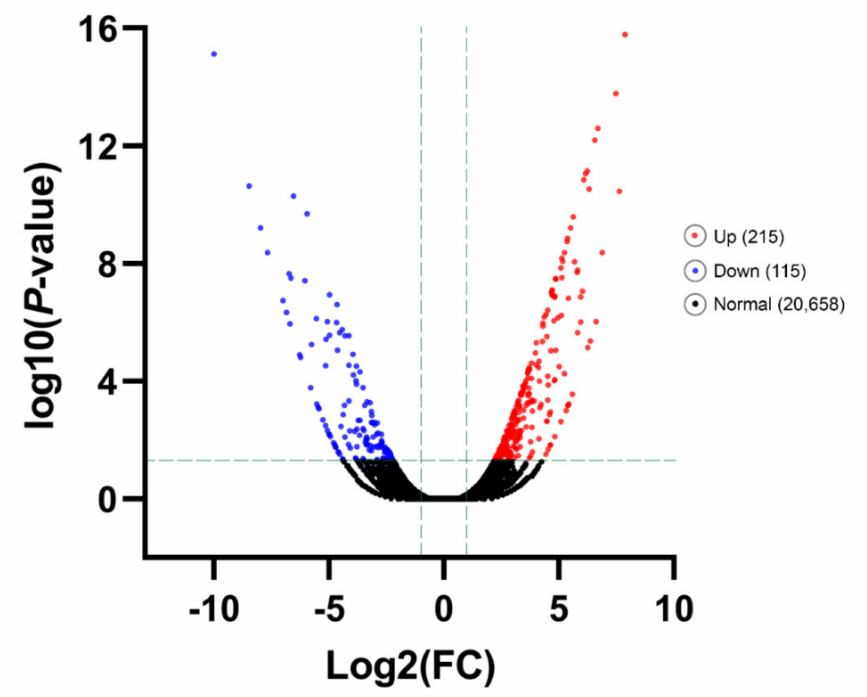
Figure 3. Significant Differentially Expressed Gene (DEG) analysis. The number of all up- and down-regulated contigs based on p -value < 0.05 and log 2 FC ≥ 1 or log 2 FC ≤ − 1 of comparison pairs was plotted. Volcano diagram for distribution of the identified DEGs in treatment group T9 in comparison with T25 as control was plotted. Red and blue points represent the significant DEGs with p -value < 0.05 and log 2 FC ≥ 1 or log 2 FC ≤ − 1 and black ones show those without significant DEGs,